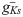
Cortical network model of cholinergic modulation.(A.) Our network model consists of a square lattice split into an excitatory and an inhibitory layer. A connectivity scheme balancing short-range excitation and global inhibition was used to mimic the lateral inhibition motif seen in many areas of the cerebral cortex. (B.) Examples of spike-frequency adaptation (SFA) induced by the slow potassium conductance are shown for gKs¯ = 0.75 mS/cm2 (top) and gKs¯ = 1.5 mS/cm2 (bottom). The red dots indicate the spike times of the neuron in question and illustrate the the offset of an upstate corresponds to the maximal level of gKs¯. (C.) The phase response curve of individual neurons shifts from type 1 to type 2 as gKs¯ increases. (D.) An illustration of the dynamics sampled by scanning inhibitory strength, (w
i → e), and gKs¯. In a general sense, the spatial scope of activity is determined by the excitatory/ inhibitory balance and the temporal scope of activity is determined by the strength of SFA. Key: (1) quiescent (2) mixed dynamics, (3) stationary bump (4) traveling bump (5) global high frequency activity (6) multiple interacting bumps (7) planar wave (8) global burst.